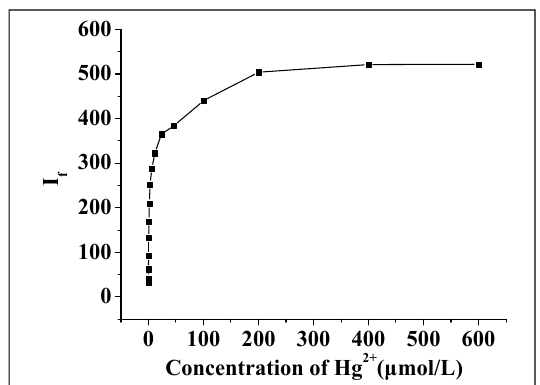
Figure 9. Relationship between fluorescence intensity and the concentration of Hg(II). Molecules 2018 , 23 , x